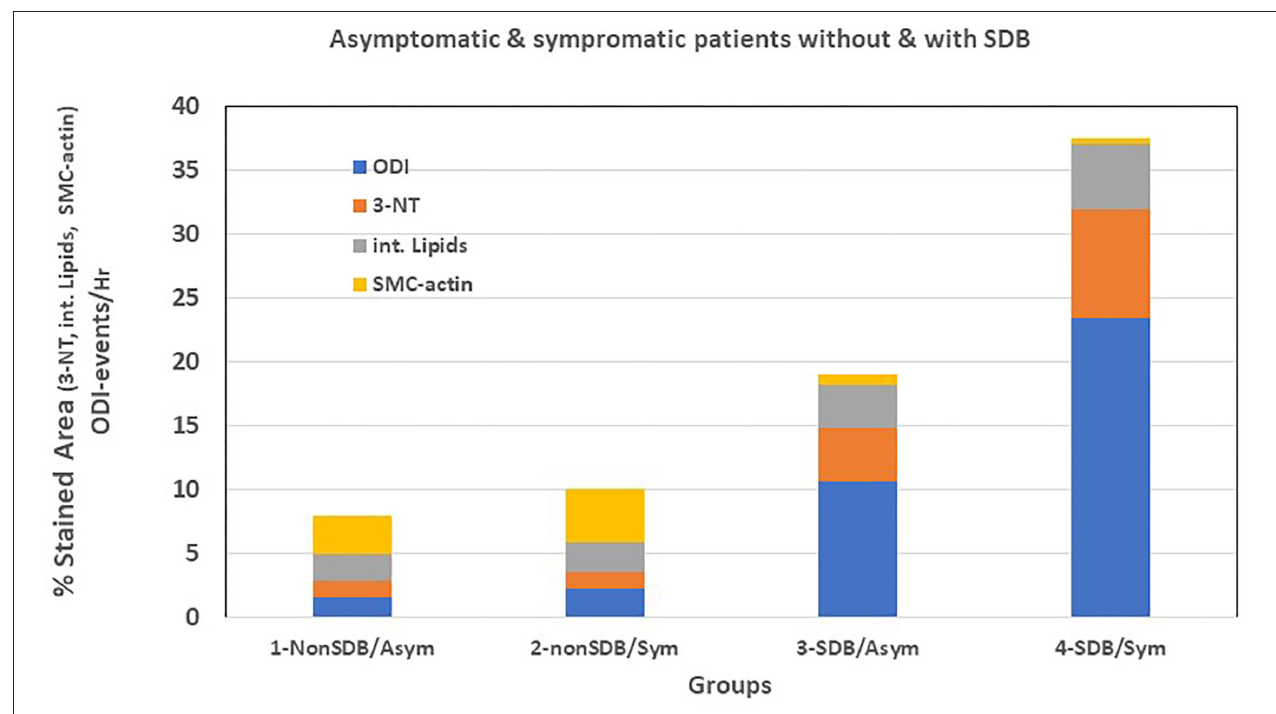
FIGURE 1 | Graphic representation of Table 5